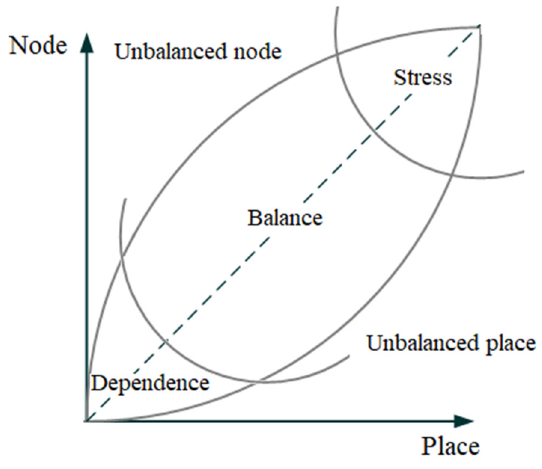
Figure 1. The NP model [17].